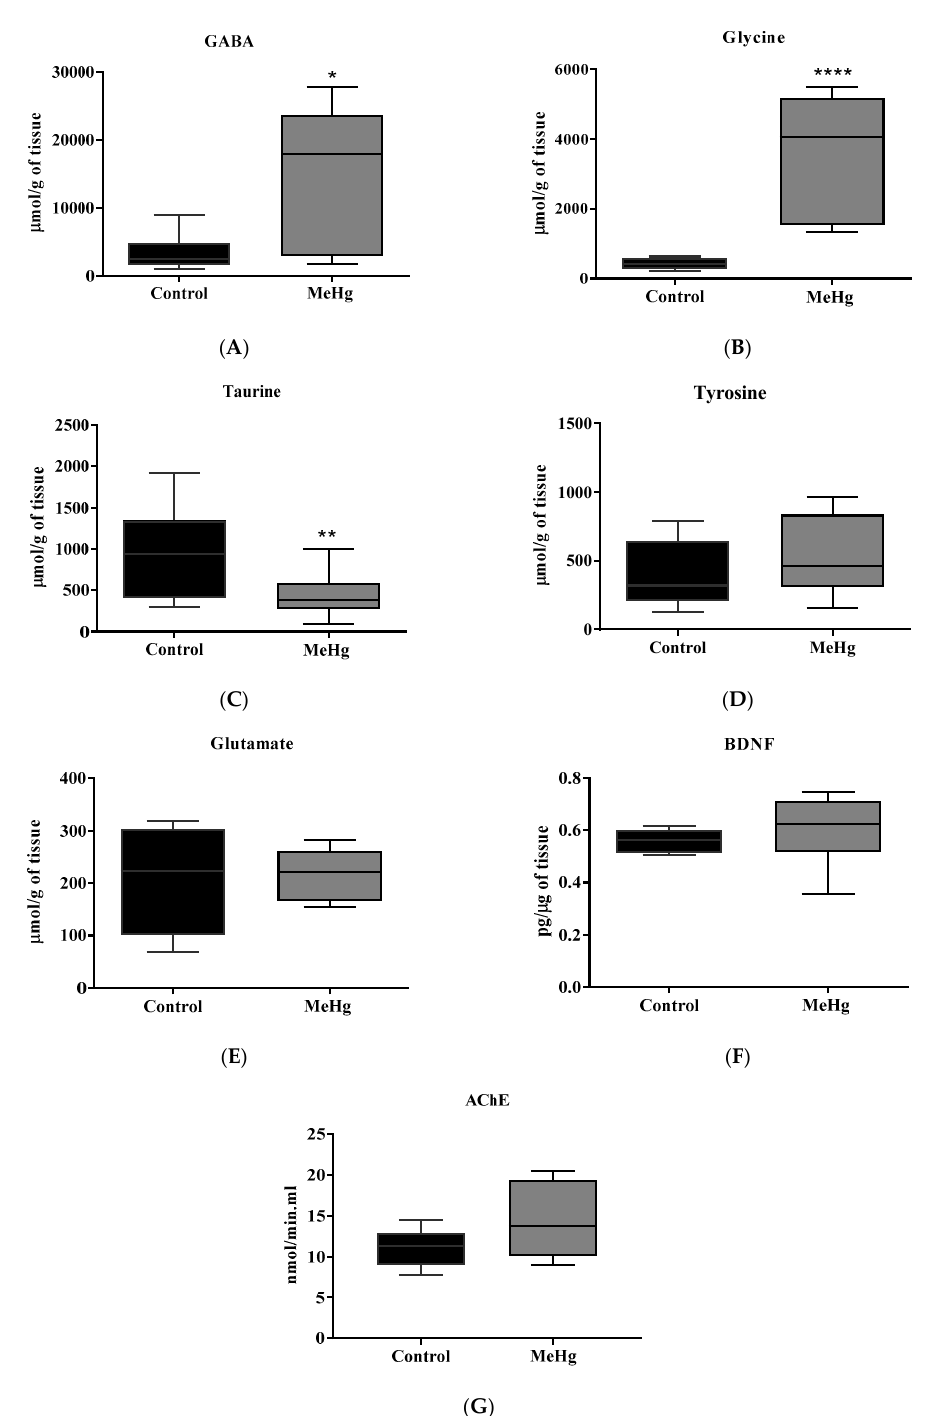
Figure 4. MeHg hippocampal amino acid levels. ( A – E ) Effect of oral administration of MeHg (2 mg/L) over 30 days on the hippocampal concentration of GABA, glycine, taurine, glutamate, and tyrosine. Values are expressed as the mean ± SEM, n = 8 per group. * p = 0.01, ** p = 0.003, **** p < 0.0001 by the unpaired Student t -test. ( F ) Effect of oral administration of MeHg (2 mg/L) over 30 days on the BDNF hippocampal concentration. Values are expressed as the mean ± SEM, n = 8 per group. ( G ) Effect of the oral administration of MeHg (2 mg/L) over 30 days on the hippocampal acetylcholinesterase (AChE) activity of adult C57BL6J mice. Values are expressed as mean ± SEM, n = 8 per group by the unpaired Student t